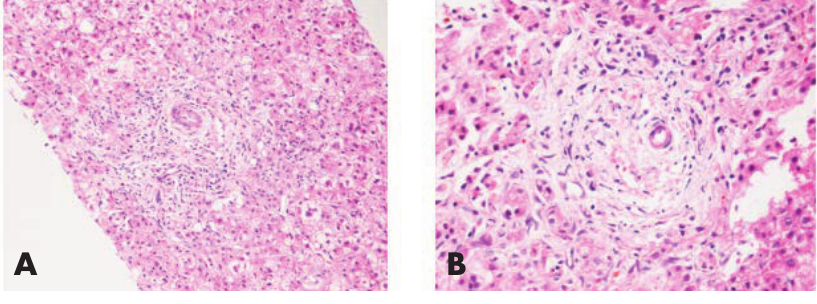
Figure 1. Histological findings demonstrating PIBD in patient 1. A) Portal area with mid chronic inflammation with visible hepatic artery branch and portal vein branches with- out any native bile ducts. There are surrounding giant cell transformation of hepatocytes. B) Another portal area showing hepatic artery and portal vein without a native bile